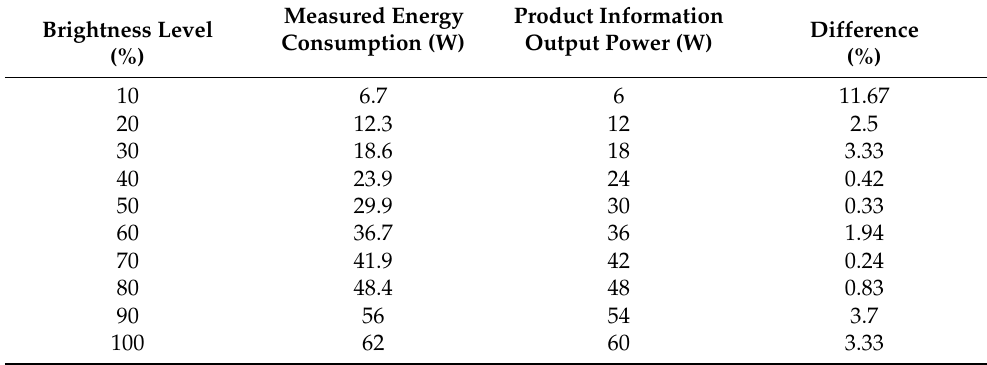
Table 3. The energy consumption of an LED lamp in various brightness